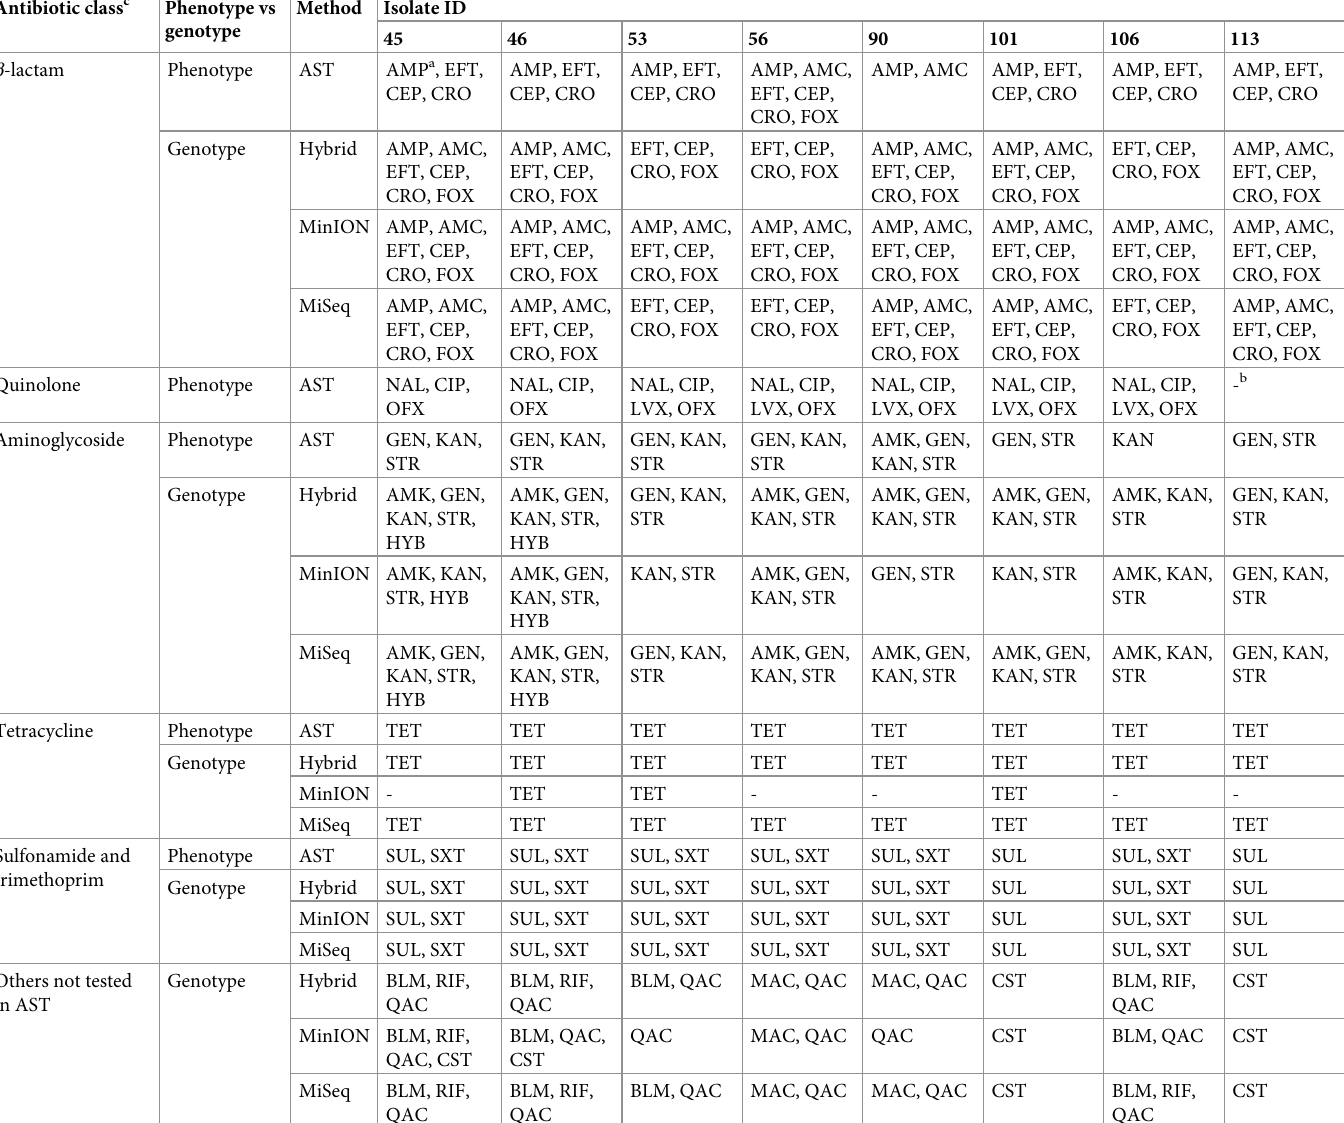
Table 3. Antimicrobial resistance (AMR) phenotypes of S . Typhimurium isolates, and their corresponding AMR genotypes, as predicted based on their hybrid, MinION, and MiSeq